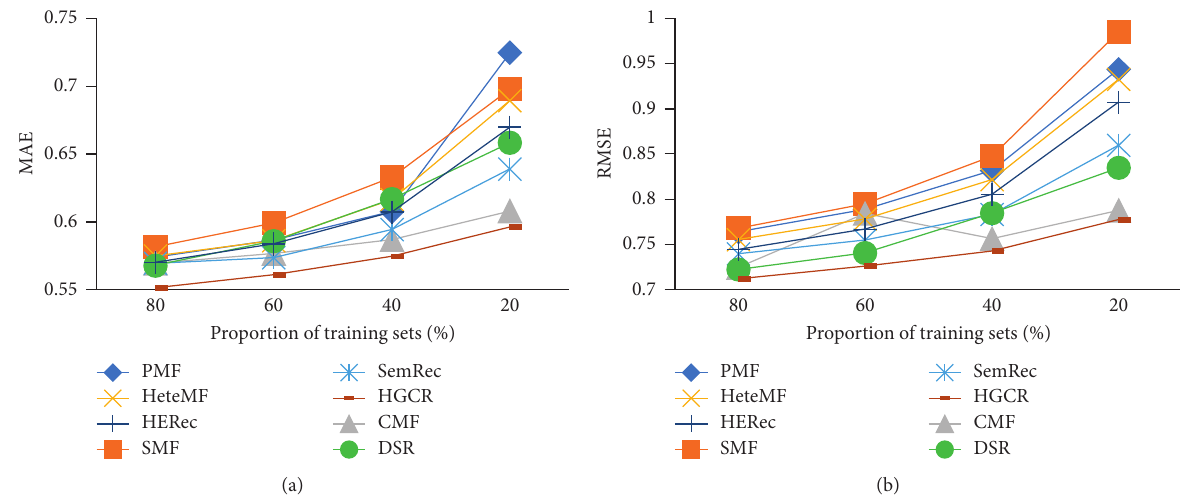
Figure 4: Performance of Douban Movie with different algorithms. (a) MAE vs. proportion of training sets. (b) RMSE vs. proportion of training sets.